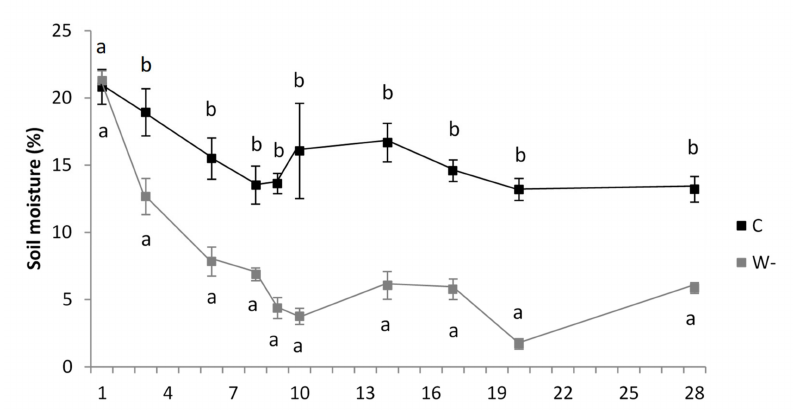
Figure 2. Soil moisture in the pots for the control (C) and water shortage (W-) treatments of the buckwheat plants. Data are means ± standard deviation ( n = 7). Di ff erent letters indicate significant di ff erences in soil moisture between treatments within each sampling day ( p ≤ 0.05; t -tests).